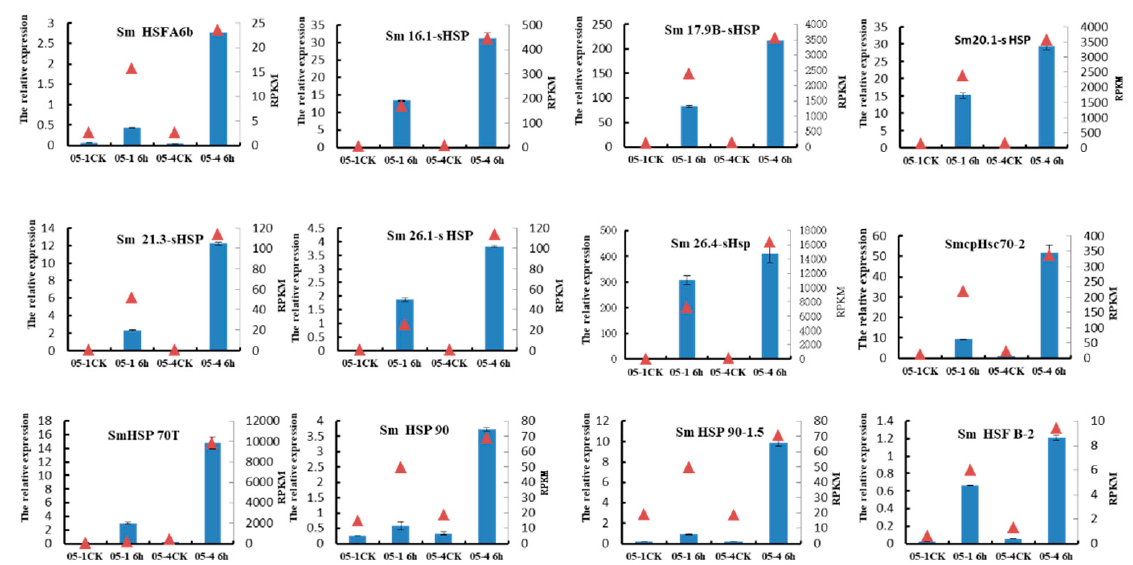
Figure 4. Comparison of transcripts expression results from RNA-seq and qRT-PCR analysis. Abscissa: Sample number; the ordinate (left): the relative expression of gene validated using qRT-PCR, represented by bar chart; coordinates (right): RPKM value obtained from the transcriptome sequencing, represented by triangle scatter diagram.